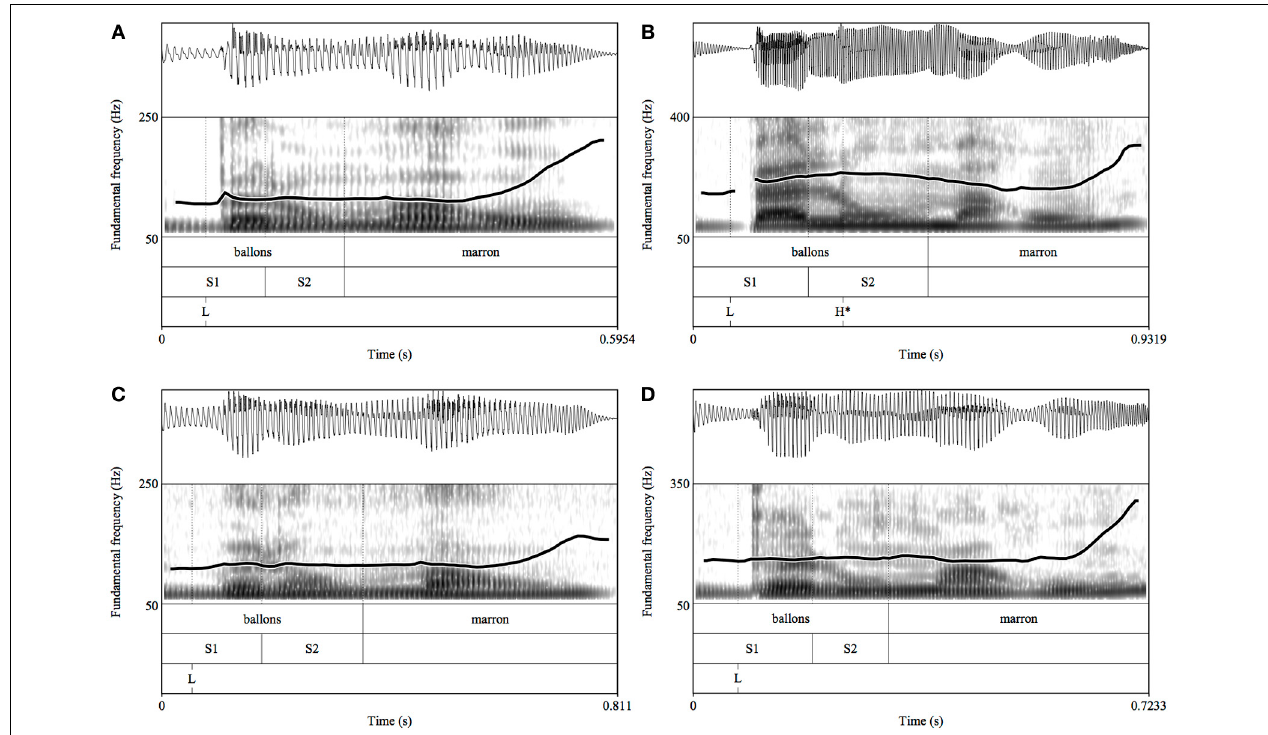
FIGURE 2 | Illustration of the annotation of two noun-adjective pairs produced either by a HC speaker in the given condition (A) and in the contrastive condition (B) or by a SZ speaker in the given condition (C)